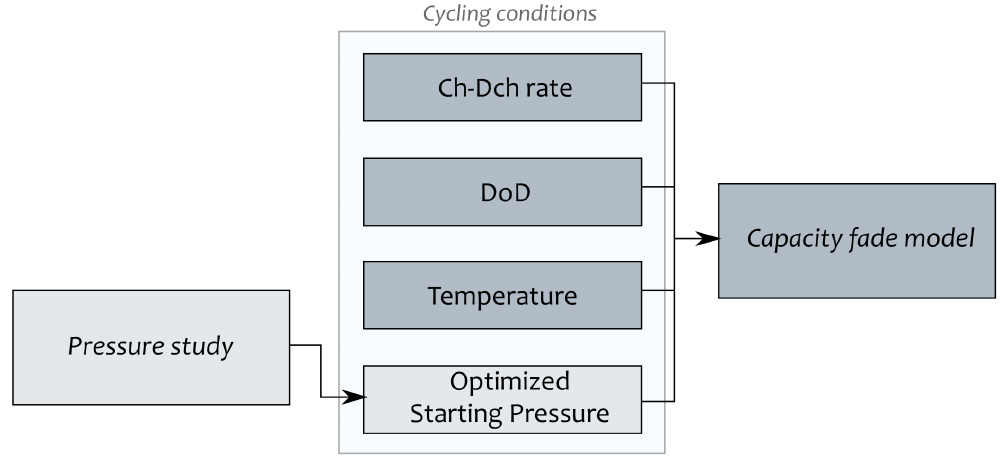
Figure 3. Overview of the performed lifetime study and developed capacity fade model of silicon